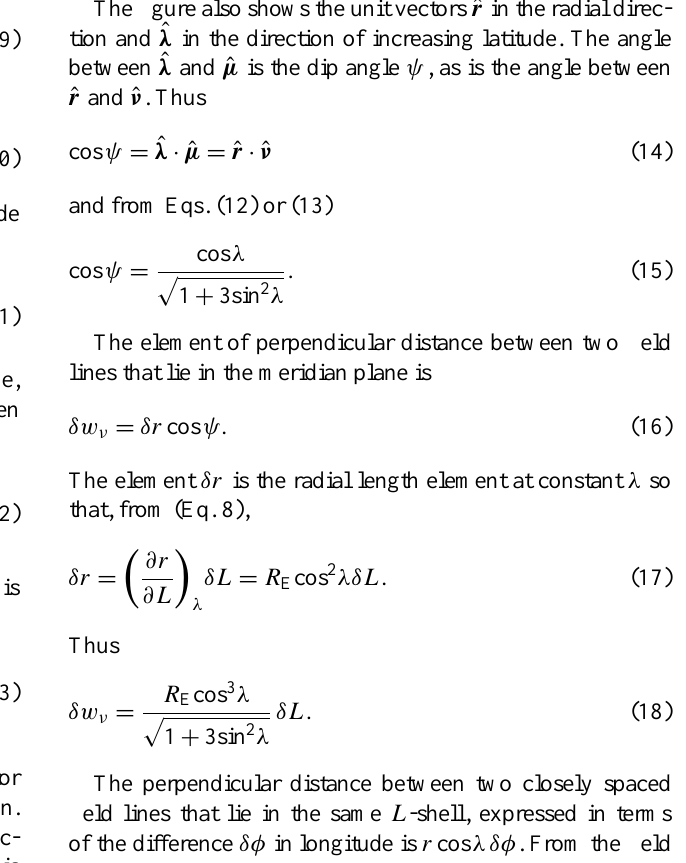
in Fig. 1. The grid at the bottom of the figure shows lines